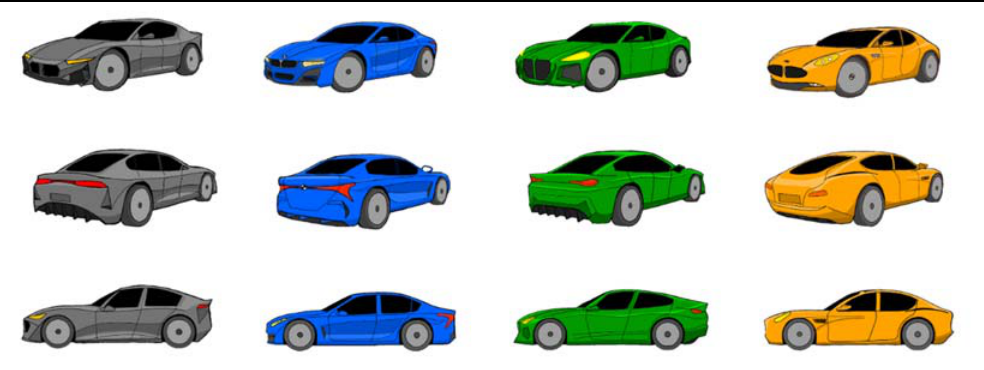
Figure 10. Sketches of the four proposals. From the left: advance, stone, nature and retro.